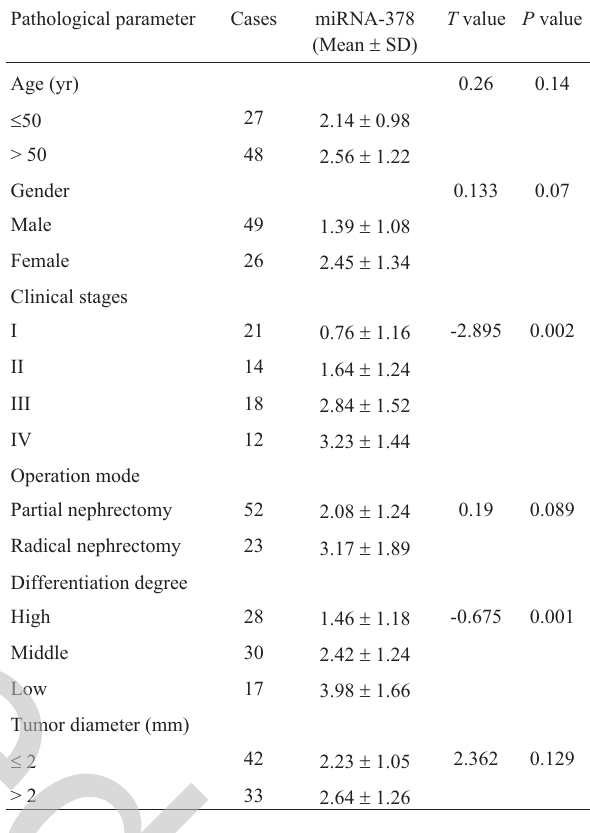
Table2 -TherelationshipbetweenmiRNA-378expressionlevelandclin- ical pathological parameters in RCC patients (n = 75). Pathological